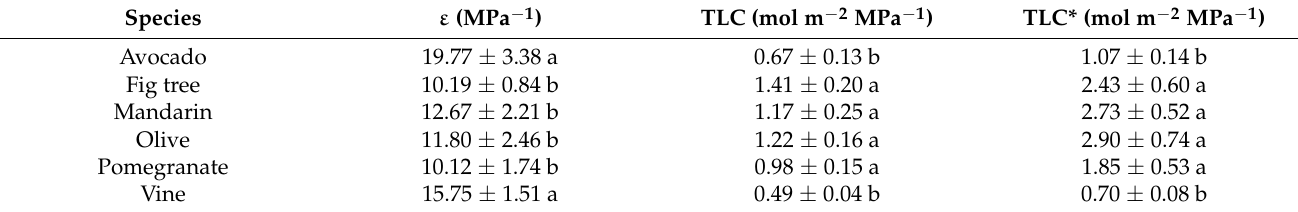
Table A2. Volume-Pressure curve